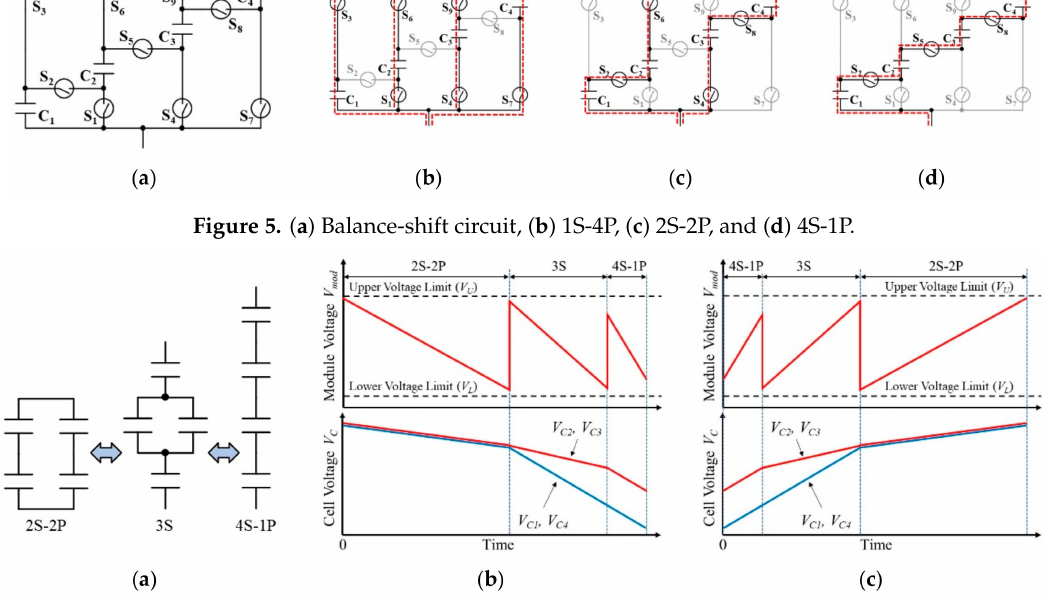
Figure 6. ( a ) Typical reconfiguration sequence of unbalance-shift circuit for four-cell module, ( b ) its discharging, and ( c ) charging profiles.